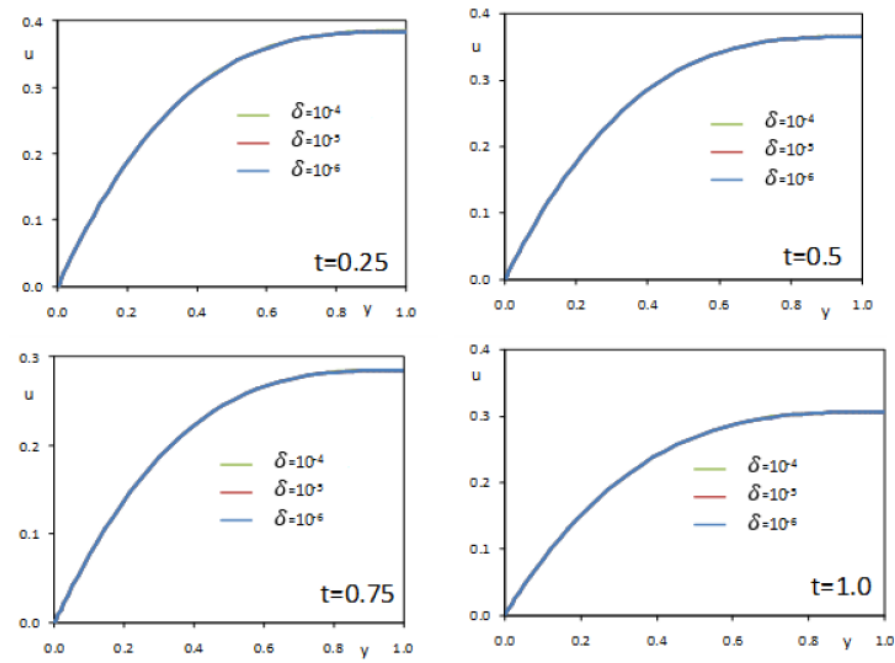
Figure 1. E ff ects of the adjustment parameter δ on the velocity profiles. n = 0.5, Re = 1, Ω = 1, and Figure 1. Effects of the adjustment parameter 𝛿 on the velocity profiles. 𝑛 = 0.5,𝑅𝑒 = 1,  = 1 , and ε = 𝜀 = 0.1 .